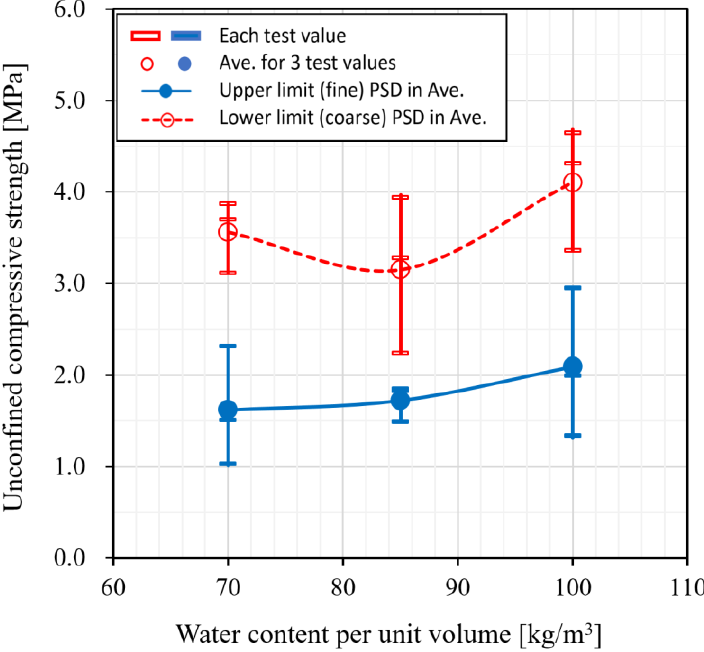
Figure 6. Change in dry unit weight according to hardfill unit water content.